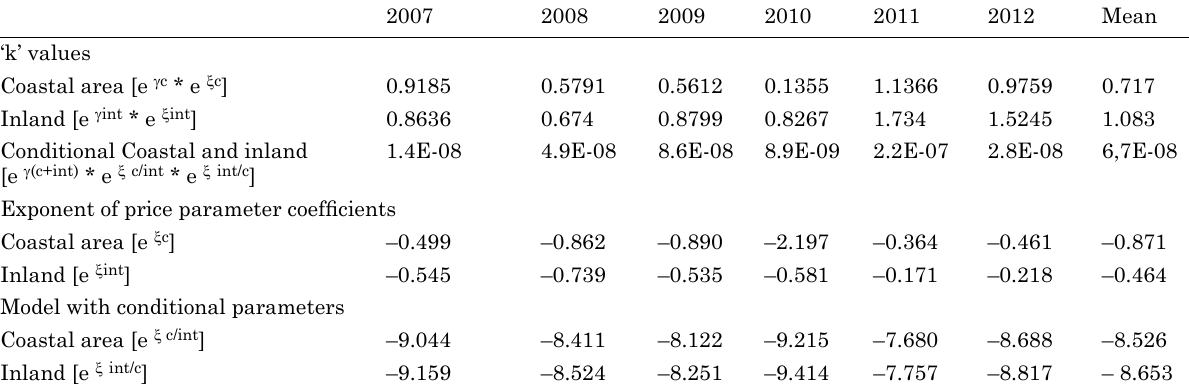
Table 3. Relative price model constancy estimation “k”